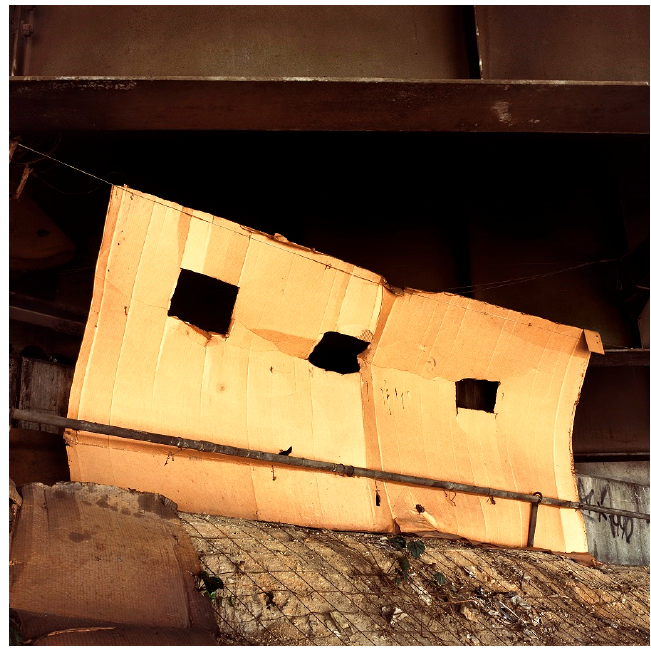
Figure 4. Anthony Hernandez, Landscapes for the Homeless #22 (1988), © Anthony Hernandez.